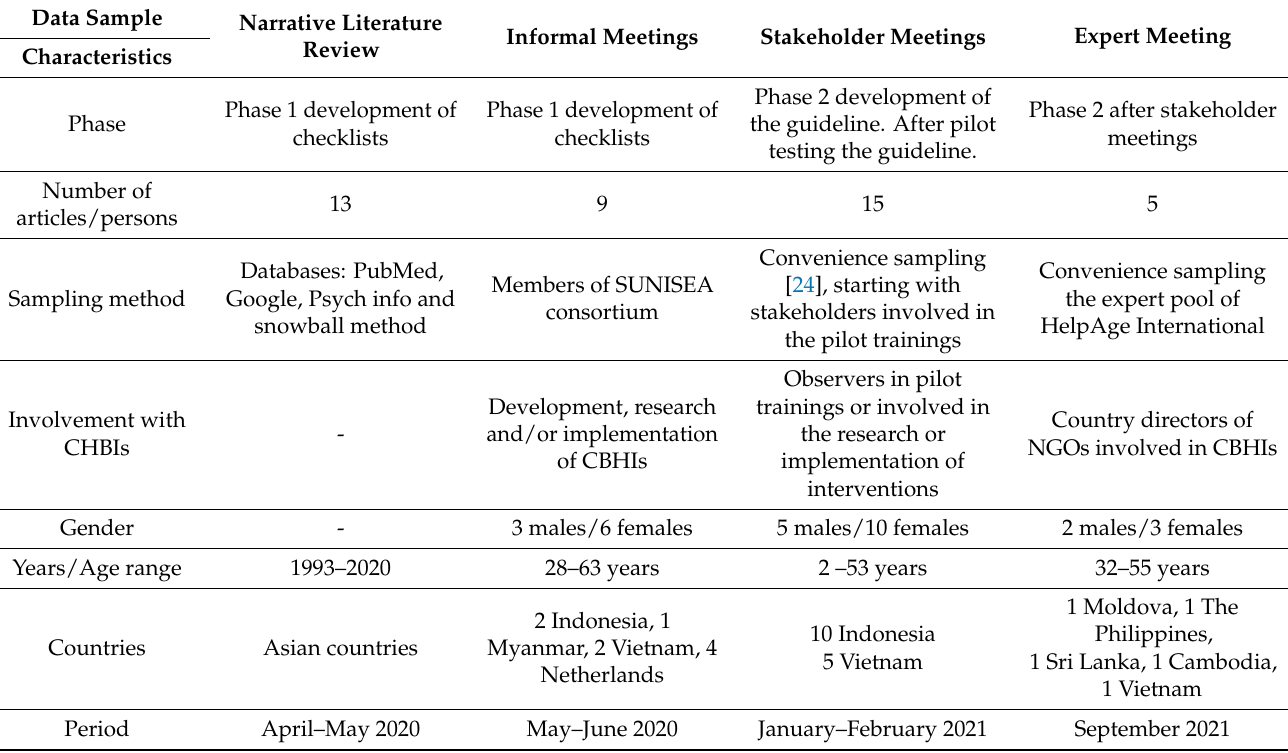
Table 1. Overview of data samples and